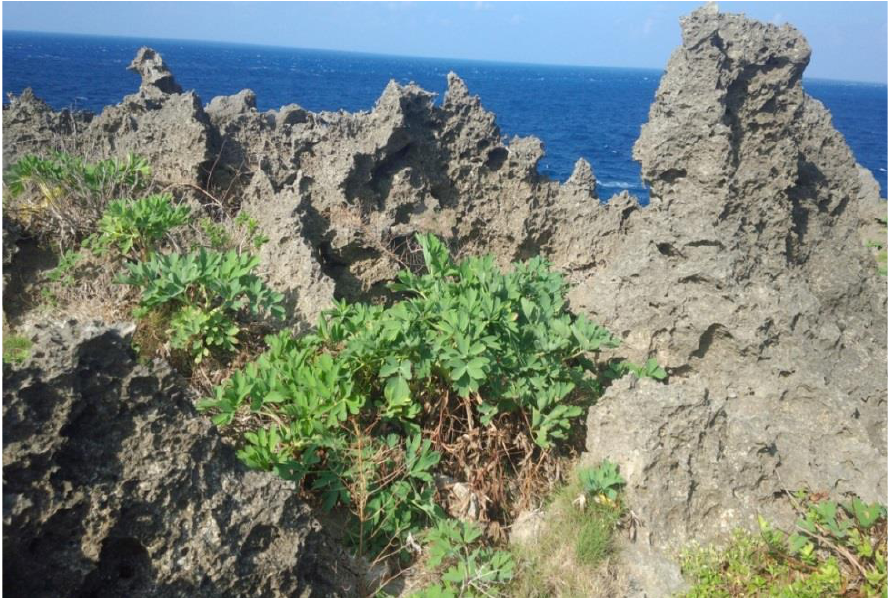
Figure 1. Peucedanum japonicum growing on a coral reef terrace on Tokunoshima Island, Central Ryukyus, Southwestern Japan.